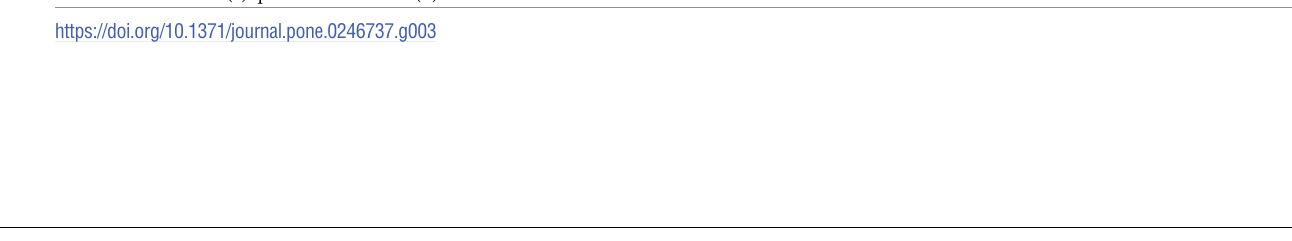
PLOS ONE | https://doi.org/10.1371/journal.pone.0246737 February 12, 2021 11 /